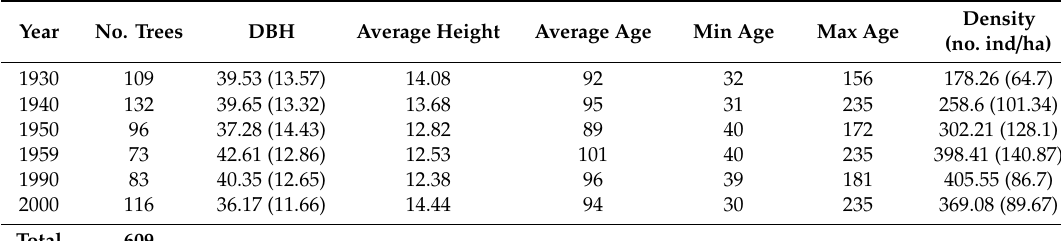
Table 1. Characteristics of Pinus sylvestris in the study area. Density values are number of individuals per ha. Values in parenthesis are standard deviation.